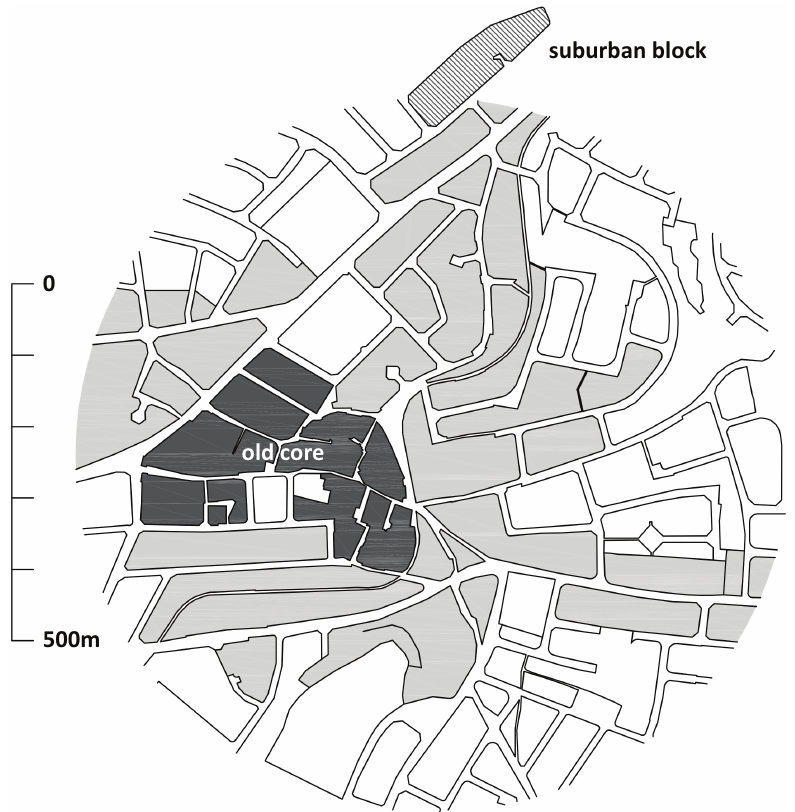
Figure 1. Pallouriotissa—Nicosia suburban development: old core (dark grey), early developed area—up to 1963 (light grey), case study block